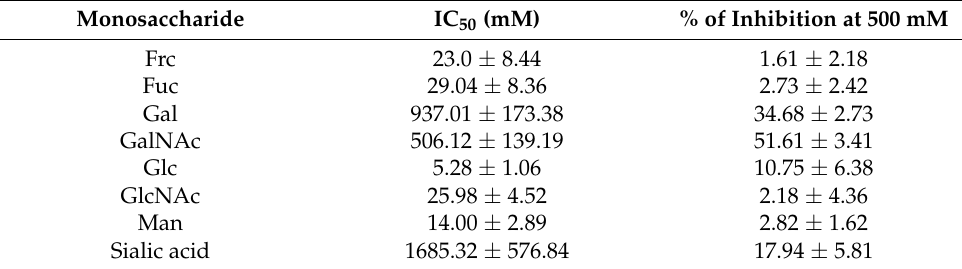
Table 2. Inhibition of the interaction of GST-RadA 35-252 with type II mucin by monosaccharides in solution. GST-RadA 35-252 was incubated with monosaccharides in solution before being added to coated type II mucin as explained in Materials and Methods. Tested monosaccharides were Fructose (Frc), Fucose (Fuc), Galactose (Gal), N-acetylgalactosamine (GalNAc), Glucose (Glc), N-acetylglucosamine (GlcNAc), Mannose (Man) and Sialic acid. IC 50 values (i.e., the concentration of monosaccharide inhibiting 50% of the interaction of GST-RadA 35-252 with type II mucin) were calculated from Figure 6 using GraphPad Prism. Results are expressed as means ± S.D. ( n = 3).